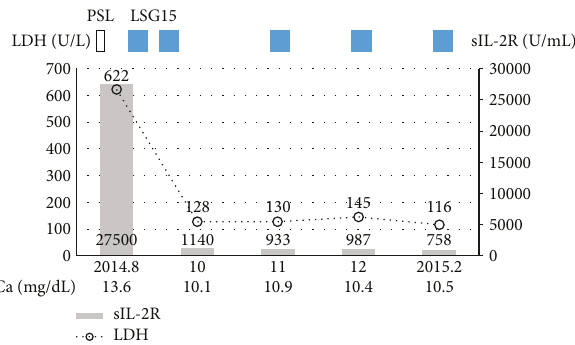
Figure 6: Clinical course of the patient. Abbreviations: PSL: prednisolone; LDH: lactate dehydrogenase; sIL-2R: soluble interleukin-2